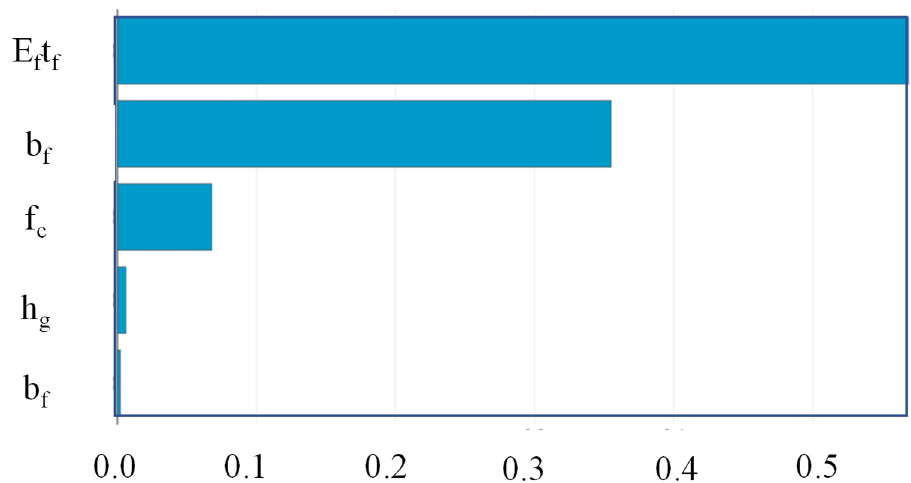
Figure 7. Feature importance of input variables using the SHAPASH library.